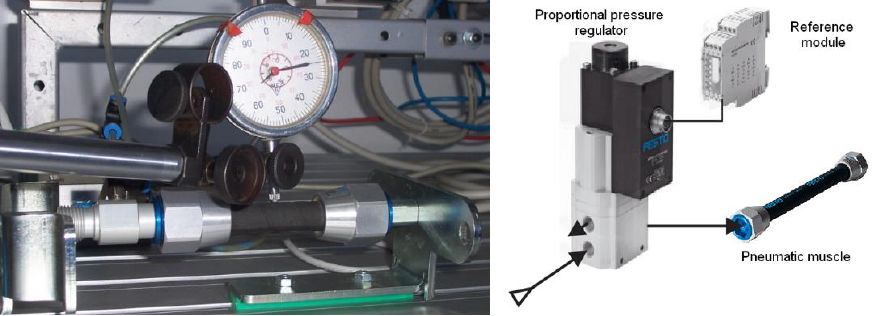
Figure 4. Measuring the radial deformations of the pneumatic muscle.